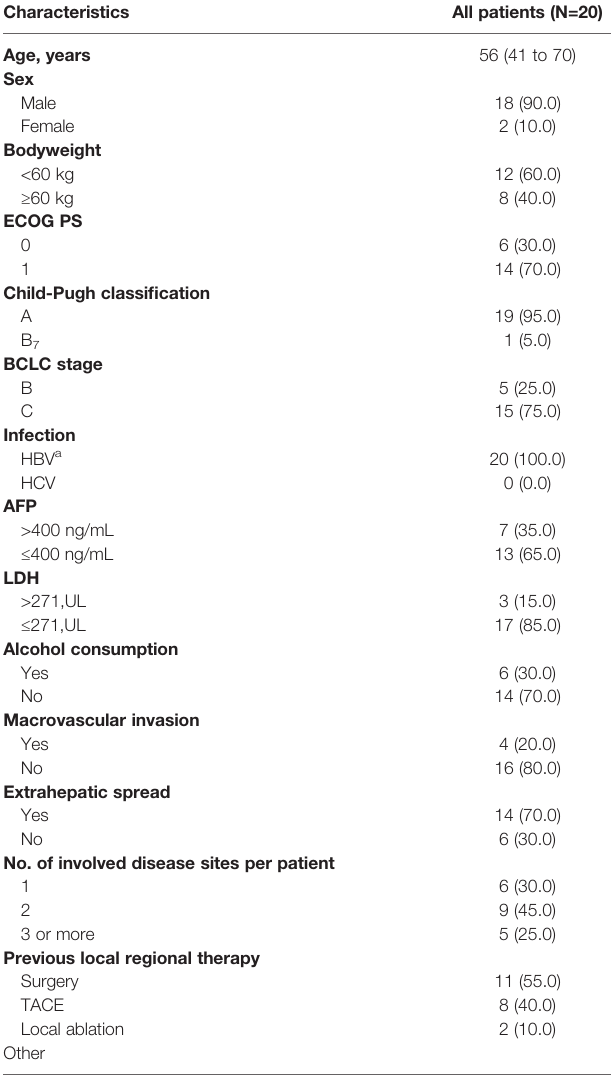
TABLE 1 | Demographics and baseline characteristics